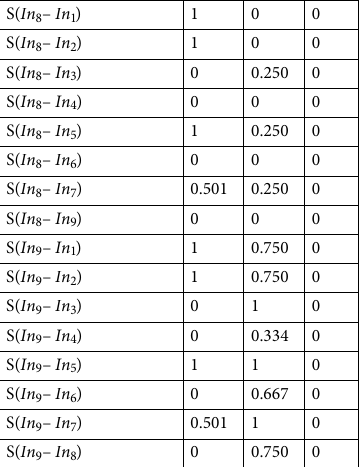
Table 5. Preference Matrix of Alternative Pairs.